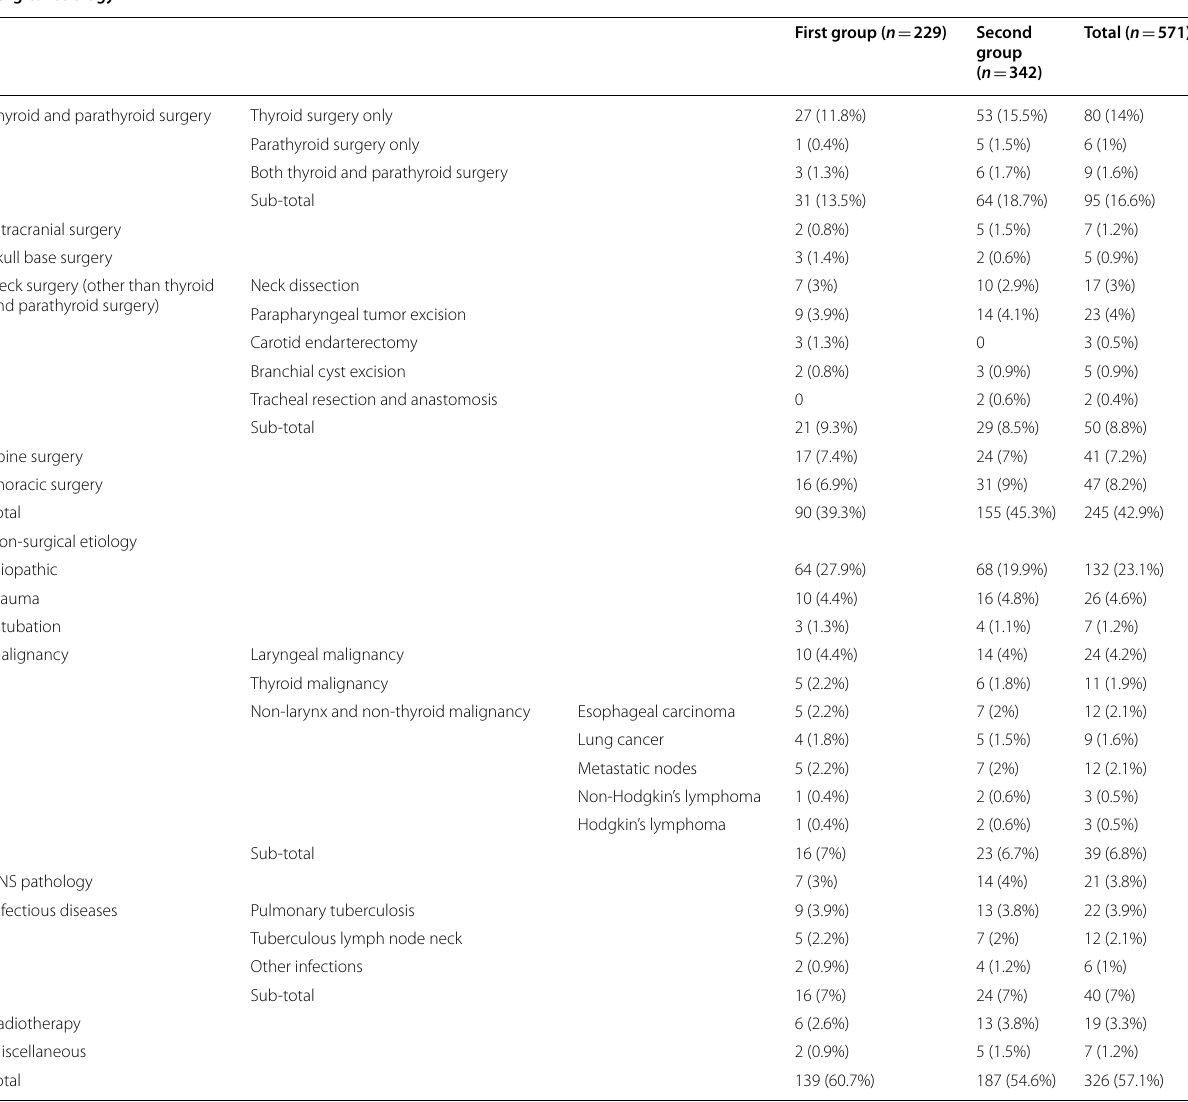
Table 1 Surgical and non-surgical etiology of UVCP Surgical